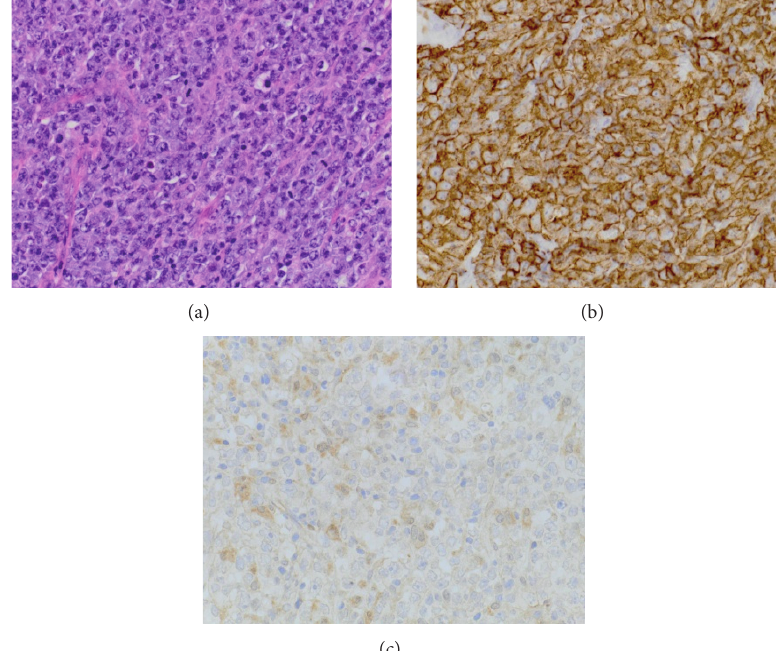
Figure 2: (a) H&E, 40x: sections of the spleen show a proliferation of highly atypical large lymphoid cells resulting in extensive effacement of the splenic architecture. The cells show irregular nuclei with open vesicular chromatin, prominent nucleoli, and moderate to scant cytoplasm. Abundant mitotic figures are seen. (b) Immunohistochemistry, CD20, 40x: the neoplastic lymphoid cells exhibit diffuse and strong staining for CD20. (c) Immunohistochemistry, 1-alpha-hydroxylase, 40x: neoplastic lymphoid cells exhibit moderate, irregular immunoreactivity for 1-alpha-hydroxylase in a cytoplasmic